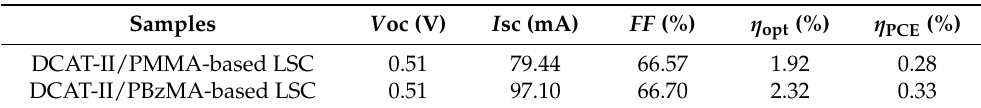
Figure 5. J–V curves of DACT-II based LSC with different polymer matrices. Table 1. Photovoltaic parameters of DACT-II-based LSC (10 × 10 × 0.3 cm 3 ) with different poly- mer II in PMMA and PBzMA matrices.